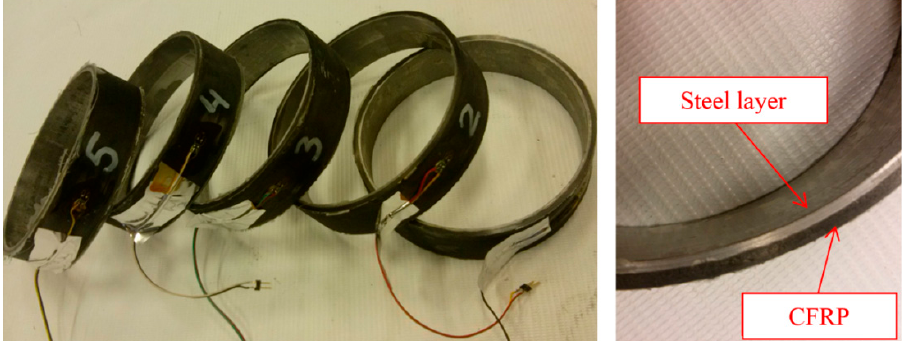
Figure 6. Manufactured